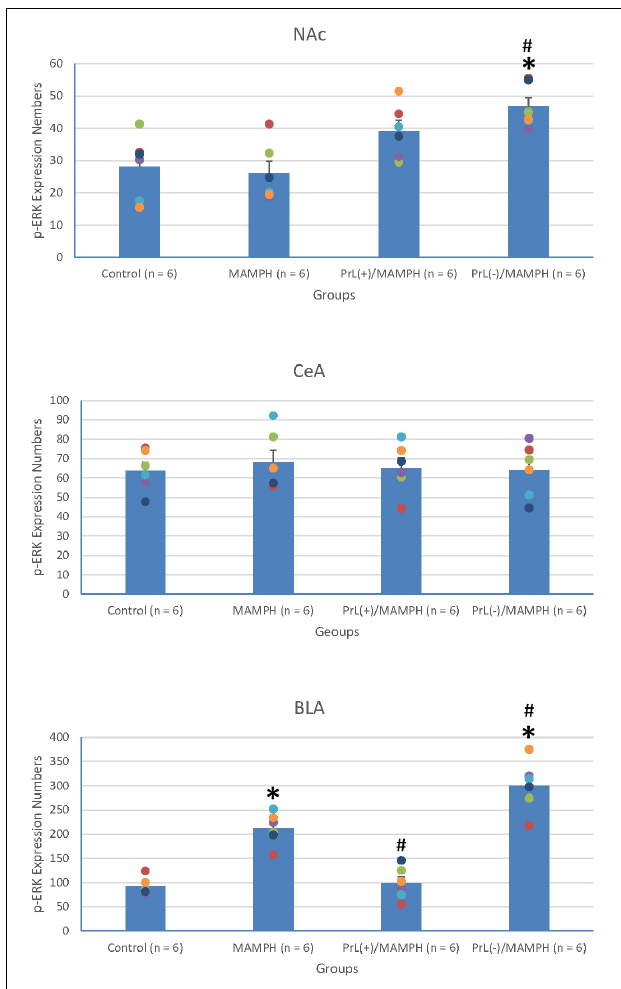
FIGURE 13 | MAMPH administrations were tested in order to label p-ERK expression in the NAc and the amygdala’s CeA, and BLA for the control ( n = 6), MAMPH ( n = 6), PrL(+)/MAMPH ( n = 6), and PrL(–)/MAMPH groups ( n = 6) by injecting NMDA or saline into the PrL. PrL(+): Injection of a low concentration of NMDA to excite the PrL neurons; PrL(–): Injection of a high concentration of NMDA to destroy the PrL neurons. Differences in p-ERK expression levels in the NAc, CeA, and BLA among all groups were analyzed by one-way ANOVA, followed by Tukey’s post hoc test if a significant difference was appeared among groups. ∗ p < 0.05 indicates significant differences compared with the control group; # p < 0.05 indicates significant differences compared with the MAMPH